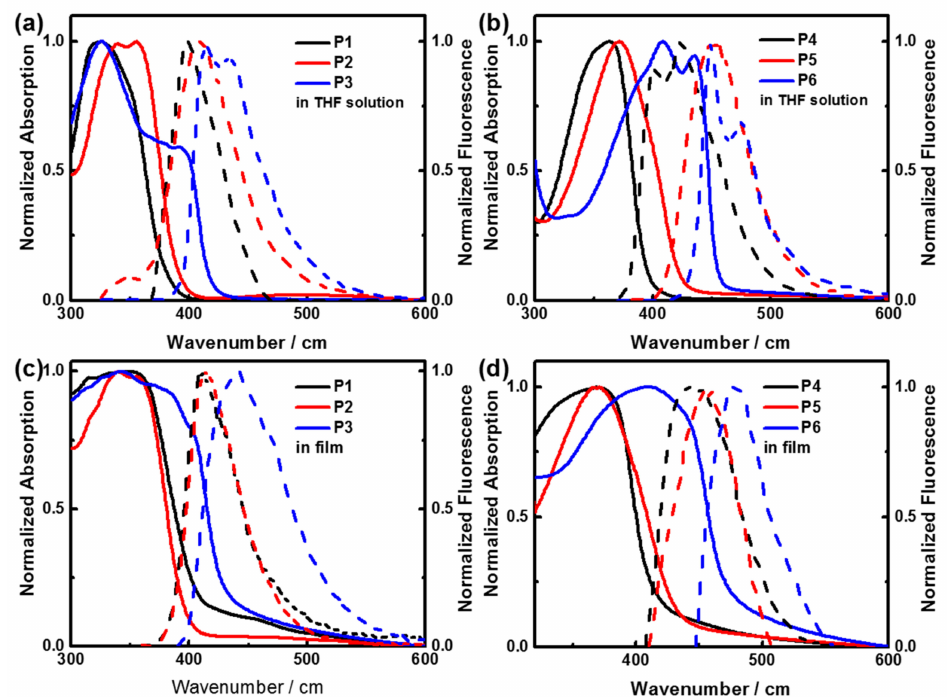
Figure 7. ( a ) Photophysical properties of polymers P1, P2, and P3 in tetrahydrofuran (THF) solution. ( b ) Photophysical properties of polymers P4, P5, and P6 in THF solution. ( c ) Photophysical properties of polymers P1, P2, and P3 in film. ( d ) Photophysical properties of polymers P4, P5, and P6 in film. The solid lines represent UV-vis absorption spectra. The dash lines indicate fluorescence emission